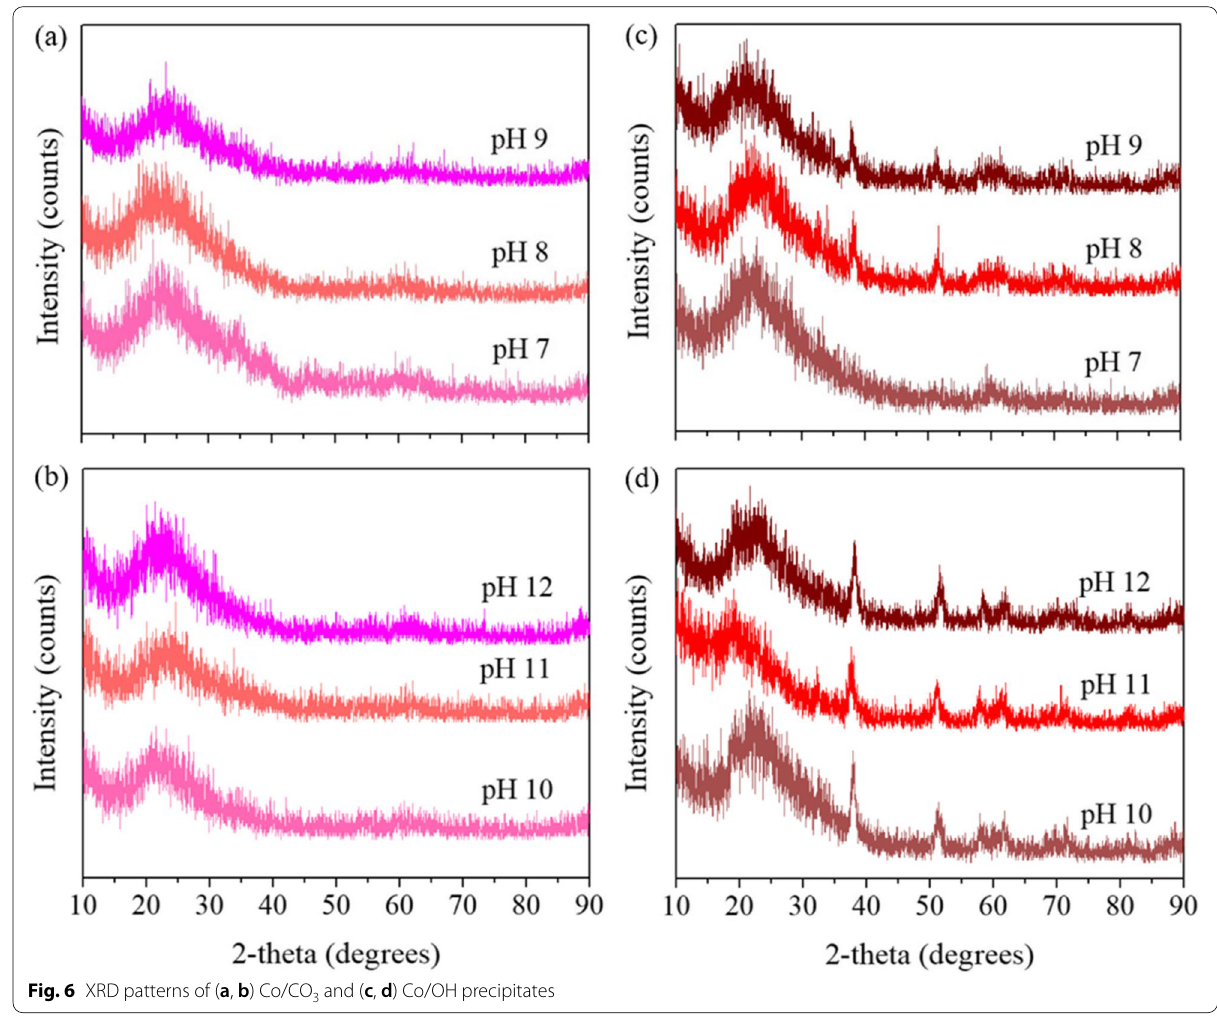
Fig. 6 XRD patterns of ( a , b ) Co/CO 3 and ( c , d ) Co/OH